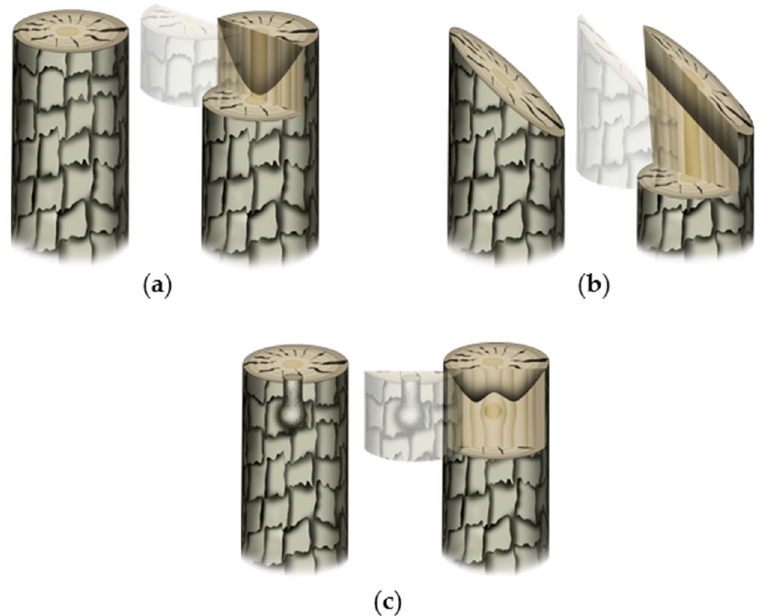
Figure 2. Typical wound-induced clogging up pattern in trees. The first and second images in each sub-figure represent wounding type/condition and virtual sectioning (for better visualization of the clogging patterns), respectively: ( a ) clean horizontal cut leads to clogging up of pith followed by side-by tissues; ( b ) oblique cut leads to the formation of the clogged-up barrier in parallelly oblique position; and ( c ) when there is a branch present beneath the cut surface, the clogging up occurs in such a way that the nutrient and metabolite flow to and from the branch would not be hindered.